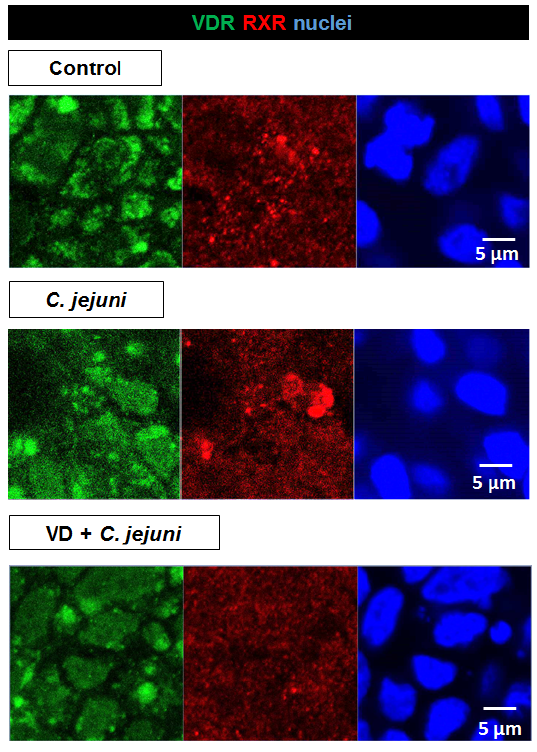
Figure 8. C. jejuni influences CYP27B1 protein expression. HT-29/B6-GR/MR cells were infected with C. jejuni from the apical side with an MOI 100 and treated with active vitamin D (VD). Cells were lysed 48 h after infection with C. jejuni , and changes in CYP27B1 protein expression analyzed by Western blot and normalized to β -actin. There were no significant differences between the groups (one-way ANOVA with Bonferroni correction, n = 9–10).